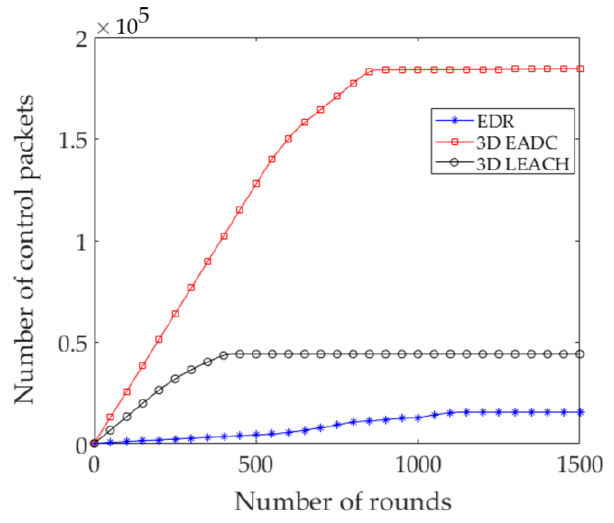
Figure 4. Number of control packets transmitted in the network.